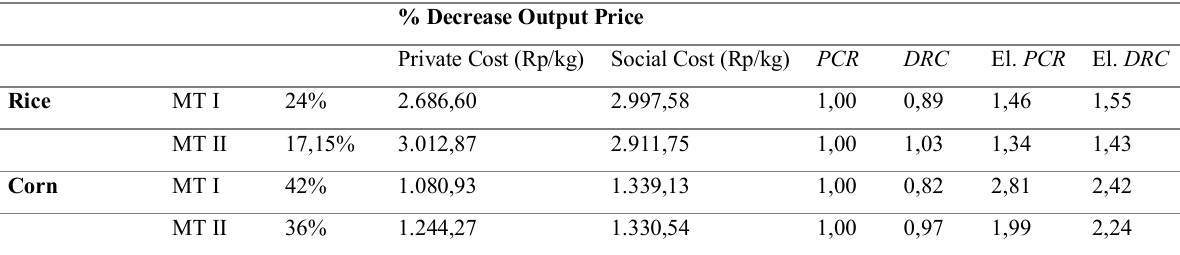
Table 8: Sensitivity Analysis of the Decrease in